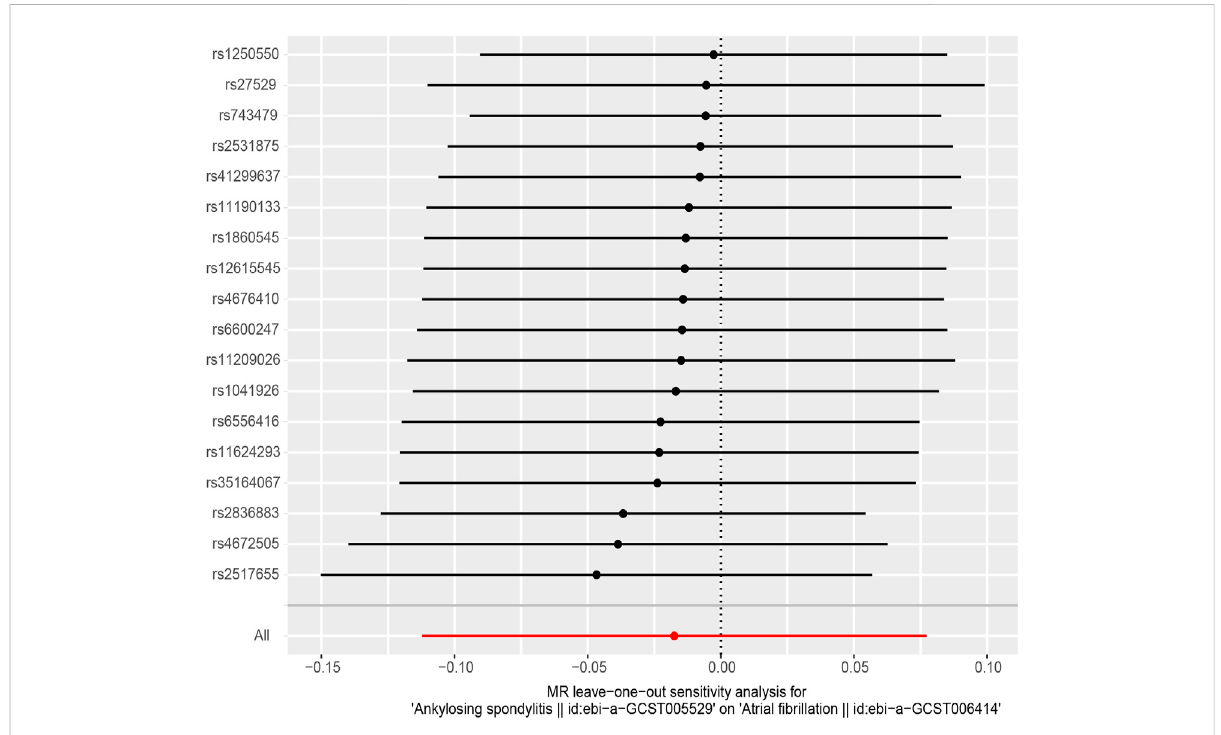
FIGURE 5 The forest plot of leave-one-out analysis.